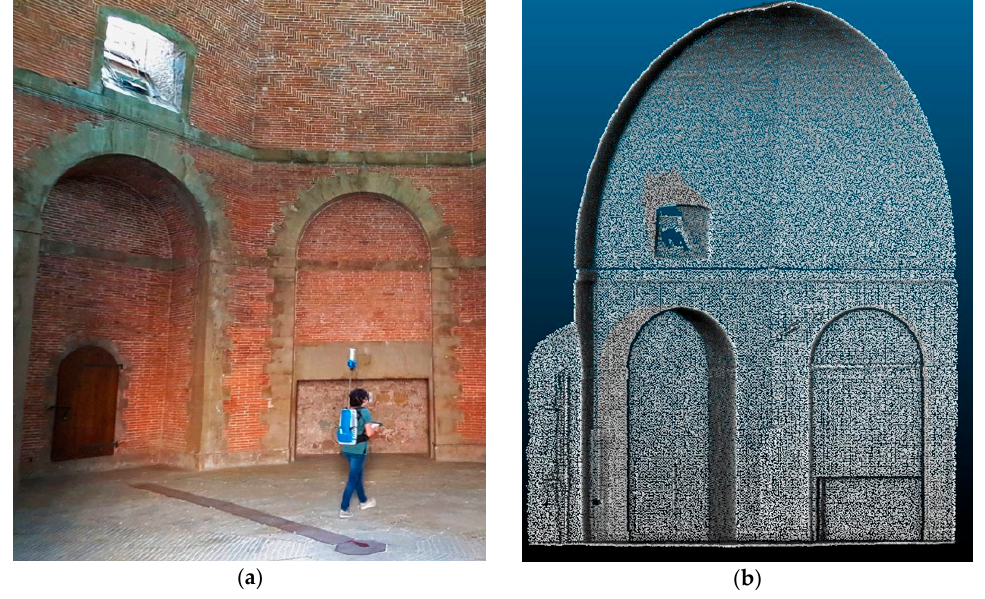
Figure 21. Octagonal room—data visualization assessment; ( a ) photo; ( b ) TLS reference dataset.